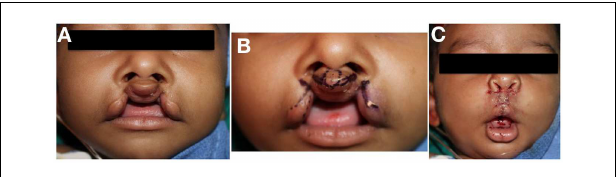
FIGURE 5 | Repair of bilateral incomplete lip . (A) Preoperative photo, (B) preoperative photo with marking, (C) status post repair.